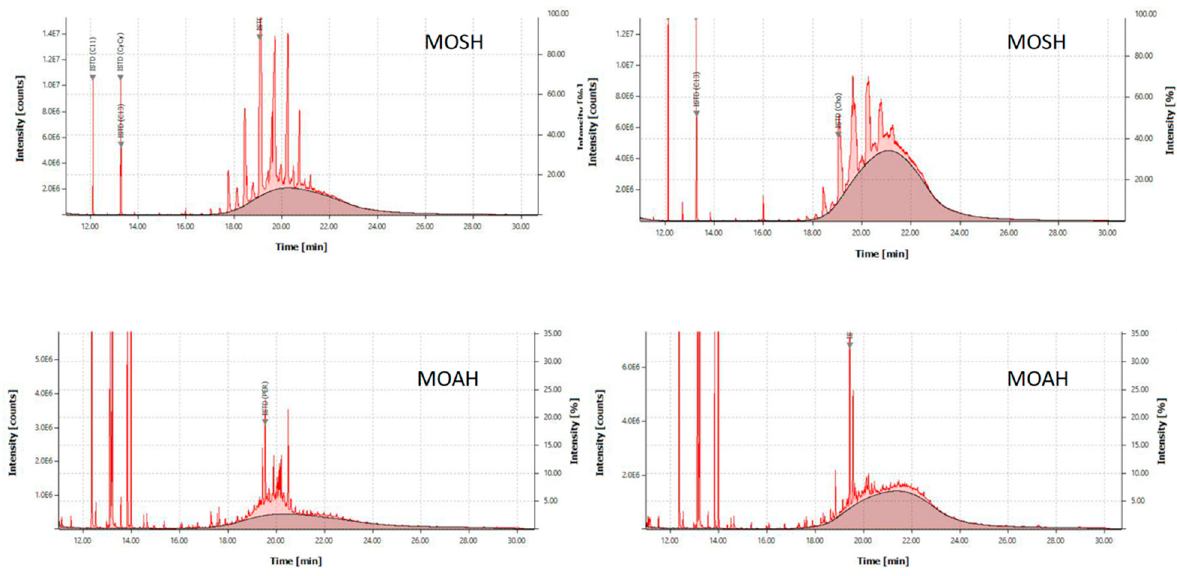
Figure 1. One-dimension HPLC-GC-FID traces of MOSH and MOAH in two (right and left) olive pomace oil samples. Hydrocarbons of plant origin and olefins can be seen on top of the MOSH and MOAH fractions, respectively. The darker areas correspond to the hydrocarbons of mineral origin .